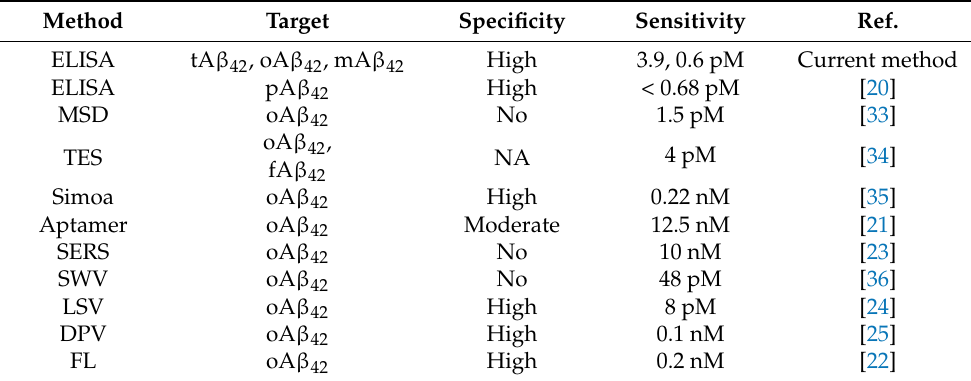
Table 1. Comparison of sandwich ELISA with other detection